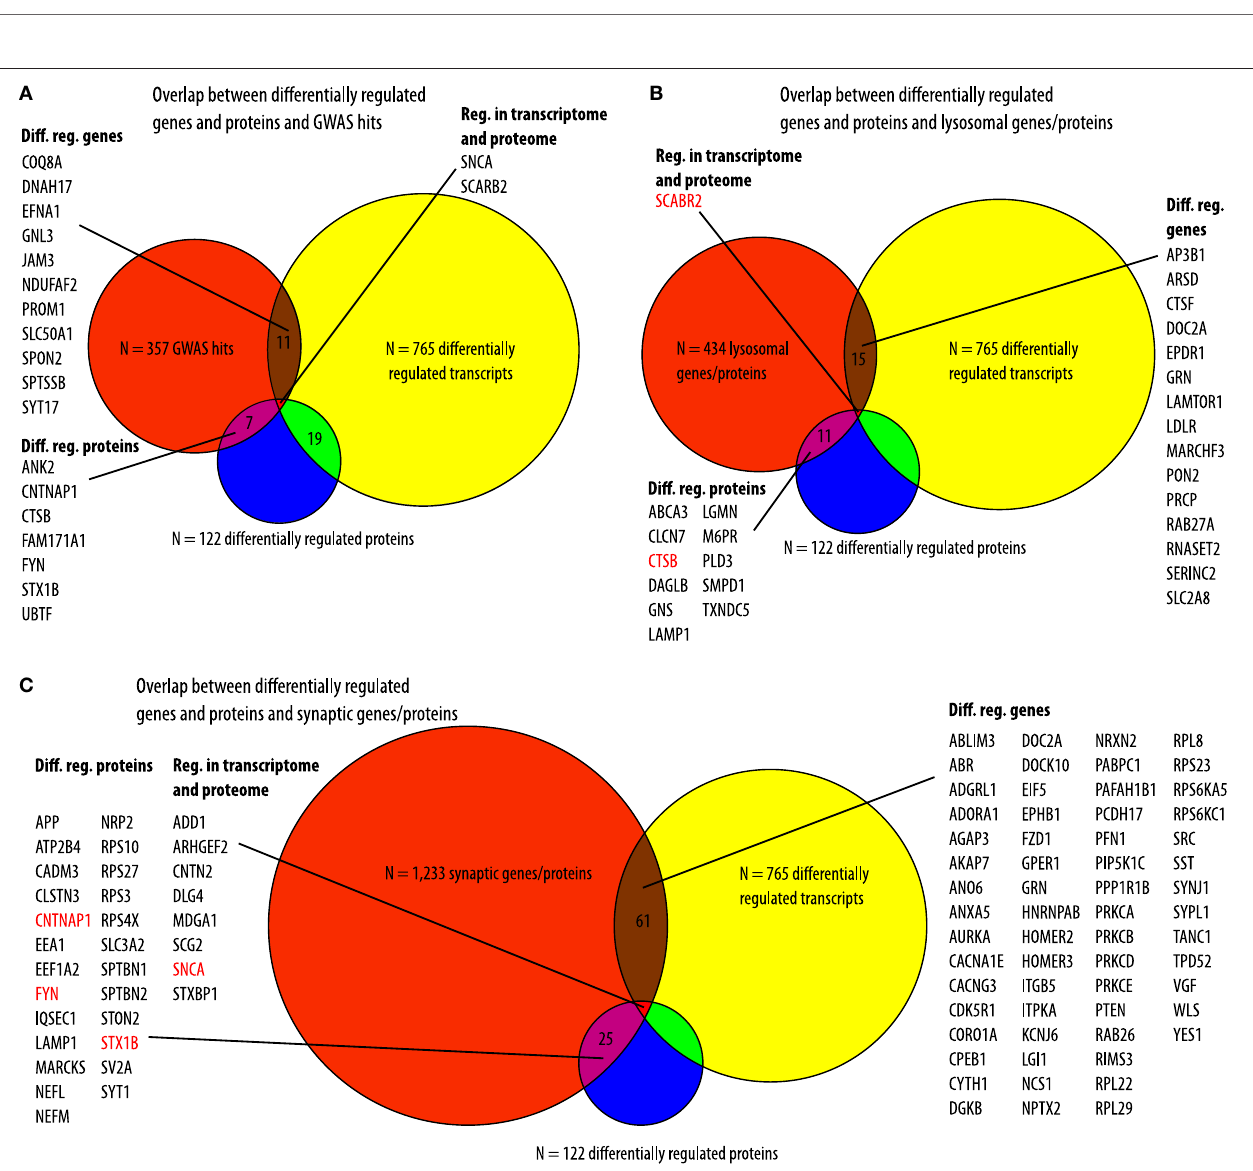
α Syn at tyrosine 125, and this phosphorylation might